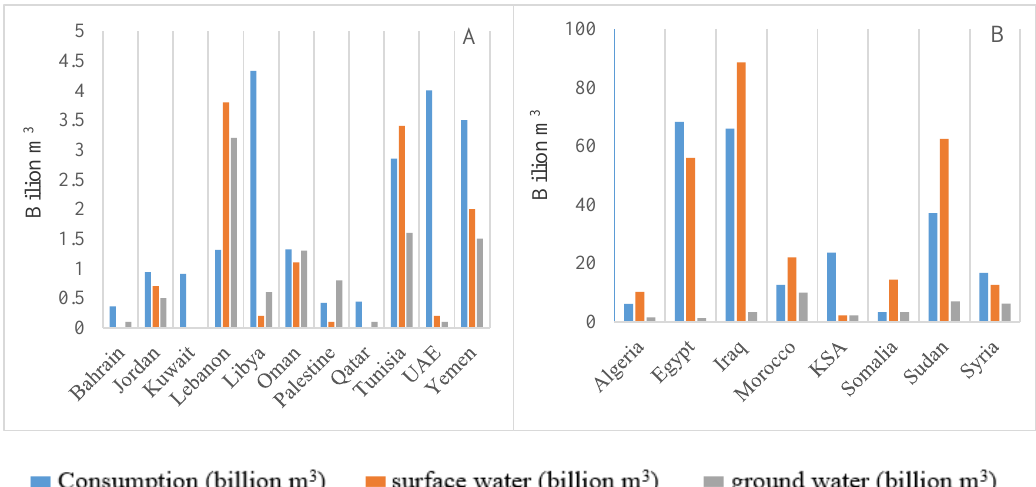
Figure 3. Water scarcity in MENA countries, ( A ): 11 countries with great scarcity, ( B ): 8 countries with moderate scarcity (data adapted from References [27–29]).